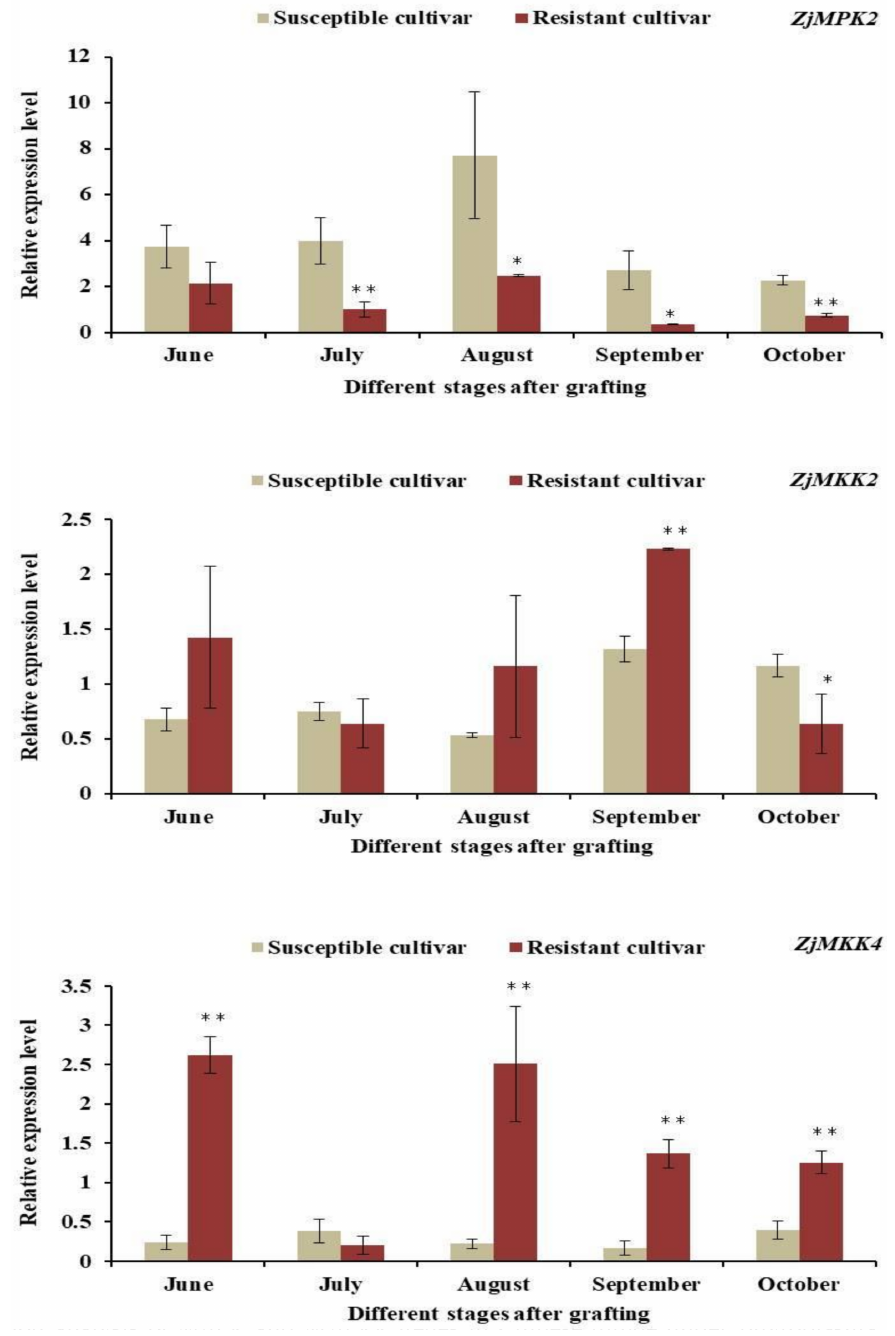
Figure 5. The expression modules of ZjMPK2 , ZjMKK2 and ZjMKK4 genes in JWB-resistant / susceptible cultivars after phytoplasma infection. ZjACT was used as the internal standard. The ‘Xingguang’ and ‘Junzao’ scions which grafted on healthy rootstocks were used as control. The mean expression value was calculated from 3 independent replicates. The vertical bars indicate the standard deviation. p < 0.05 and p < 0.01 were considered as significant (shown as *) and highly significant di ff erence (shown as **),